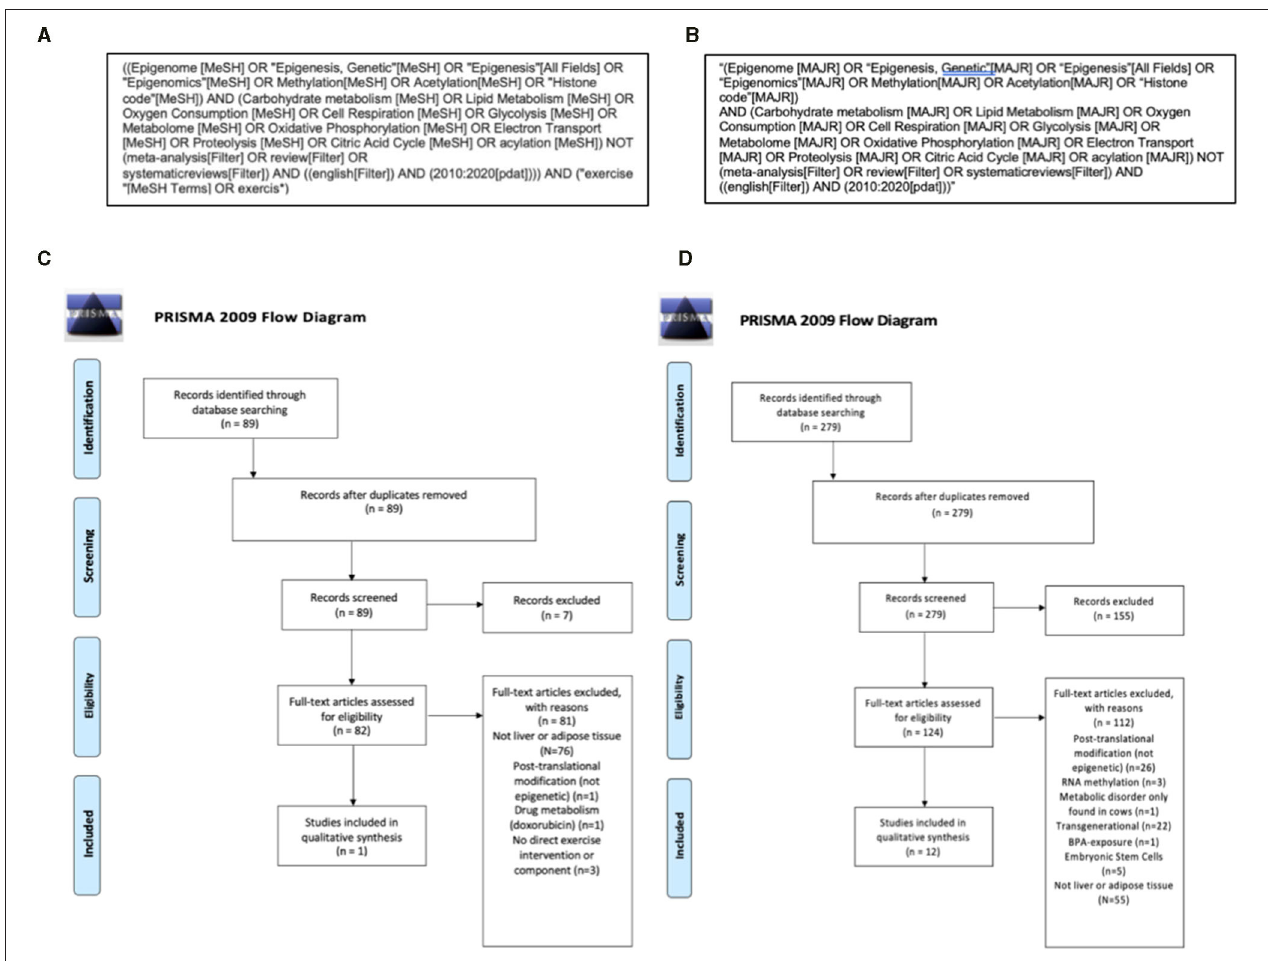
FIGURE 2 | Search strategy and Preferred Reporting Items for Systematic Reviews and Meta-Analyses (PRISMA) flow diagrams of information detailing the systematic review process. An initial PubMed search (A) identified 89, with no duplicates and completed within the last 10 years. There were 82 articles that met the following criteria: original research in the English language with full-text availability that discussed exercise, measures of both cellular metabolism and epigenetic modifications and used human, animal (mammal), or cell line models. After a more thorough screening, 82 articles were excluded for the reasons listed below and one article was included for qualitative synthesis (C) . To increase the number of articles for qualitative synthesis, as well as identify novel applications of current literature to exercise physiology, a second Pubmed search was completed that did not require an exercise component in the studies (B) . This search yielded 279 articles and after two screenings there were 12 additional articles included for qualitative synthesis (D) . Between the two searches there were 13 final articles included for